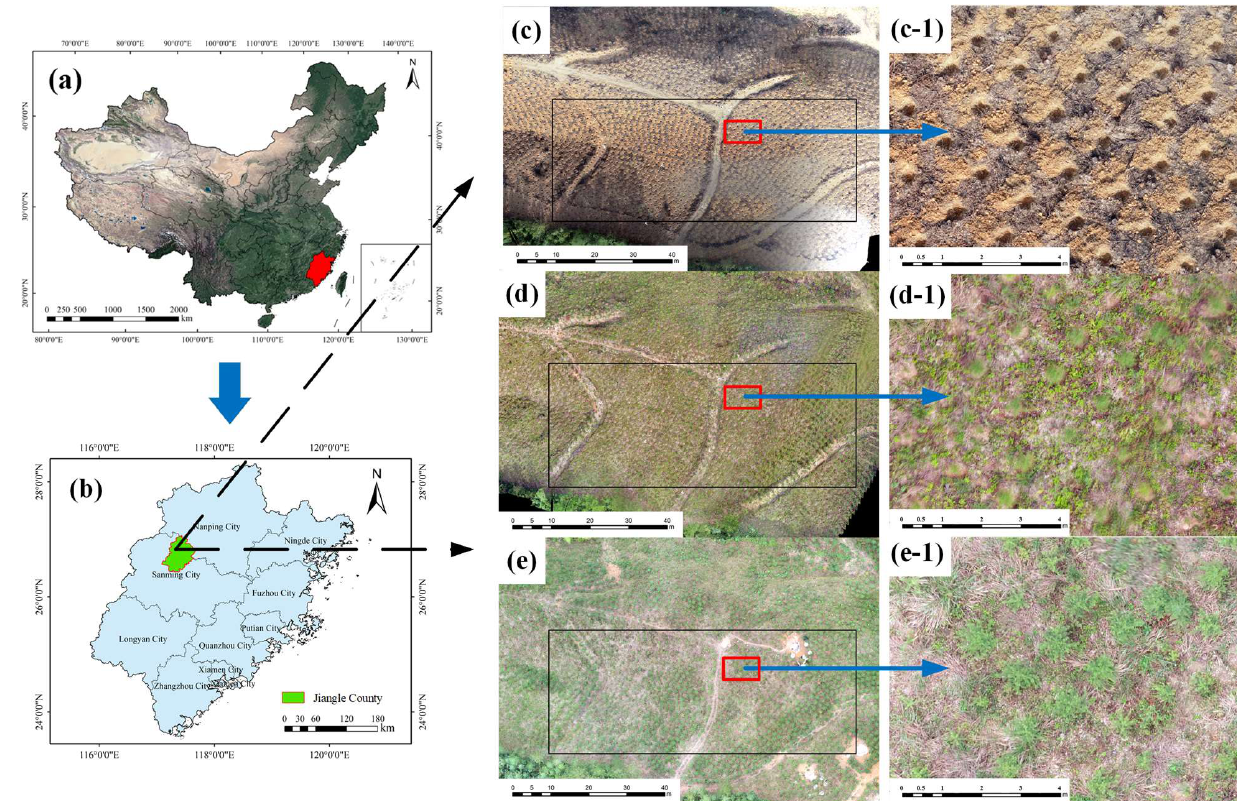
Figure 1. The study region is located in Jiangle County, Fujian Province, China. ( a ) Map of China; ( b ) Jiangle County, Fujian Province; ( c ) UAV image of tree pit on 22 January 2019; ( d ) UAV image of young forest on 2 October 2020; ( e ) UAV image of young forest on 2 October 2021; ( c-1 , e-1 , d-1 ) are magnified images in red rectangle region in ( c – d ).